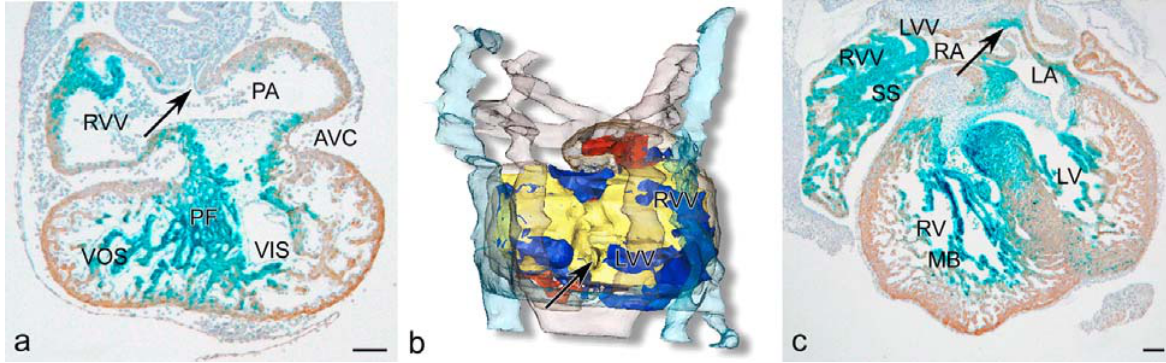
FIGURE 10. CCS- lacZ expression at the site of the developing pulmonary veins. a: Transverse section of an E10.5 murine embryo, at the level of entrance of the primitive pulmonary vein (arrow), which at this stage does not demonstrate CCS- lacZ staining. b: Dorsal view of a 3-D reconstruction of the same embryo. Ventricular myocardium, branchial arch arteries, and cardinal veins are transparent. Color codes — yellow: lumen of the common atrium and the primitive pulmonary vein (PPV); red: lumen of the common ventricle; blue: CCS- lacZ –positive myocardium. The arrow points to the primitive pulmonary vein. C: Transverse section of an E13.5 embryo, which now shows marked CCS- lacZ expression of the myocardium surrounding the pulmonary vein (arrow). Marked staining is also visible in the right ventricular moderator band (MB). Abbreviations — AVC: atrioventricular canal, LA: left atrium, LV: left ventricle, LVV: left venous valve, PA: primitive atrium, PF: primary fold, RA: right atrium, RV: right ventricle, RVV: right venous valve, SS: septum spurium, VIS: ventricular inlet segment, VOS: ventricular outlet segment. Scale bars — a: 100 μ m, c: 200 μ